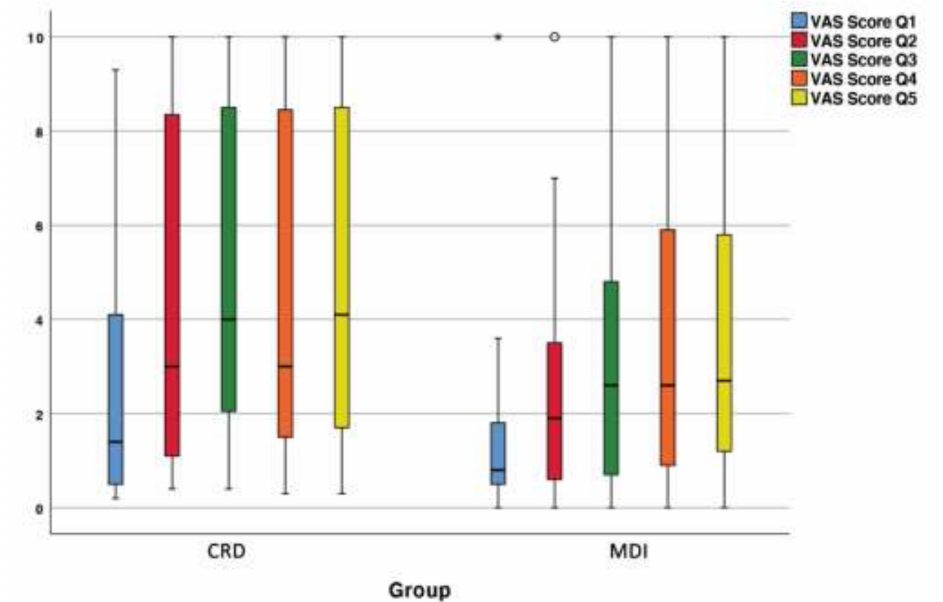
Figure 4. Mean VAS score outcome for masticating food with different con-sistencies (Q1 blue bar: soft white bread; Q2 red bar: hard cheese; Q3 green bar: hard sausage; Q4 orange bar: apple; Q5 yellow bar: carrot) comparing CRD with MDI group. There were no significant differences in the VAS score between both groups ( p > 0.05). *: Outlier.